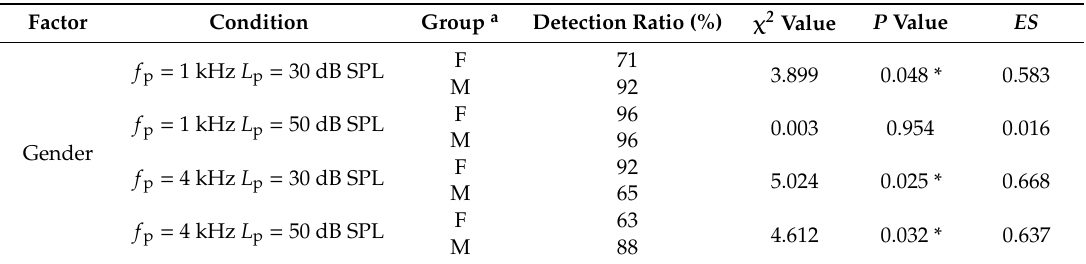
Table 1. The detection rates of SFOAE with the di ff erent factors of gender at the conditions of probe frequency and probe level.